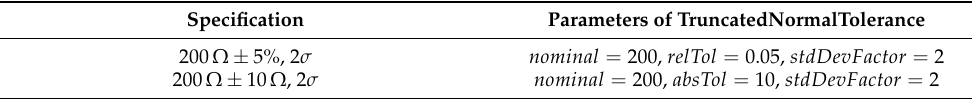
Table 2. Examples of TruncatedNormalTolerance definitions. The value 2 σ means that the limits of the truncated normal distribution are at 2 · standardDeviation (= probability of 95.4%) of the underlying (nontruncated) normal distribution, see also Figure